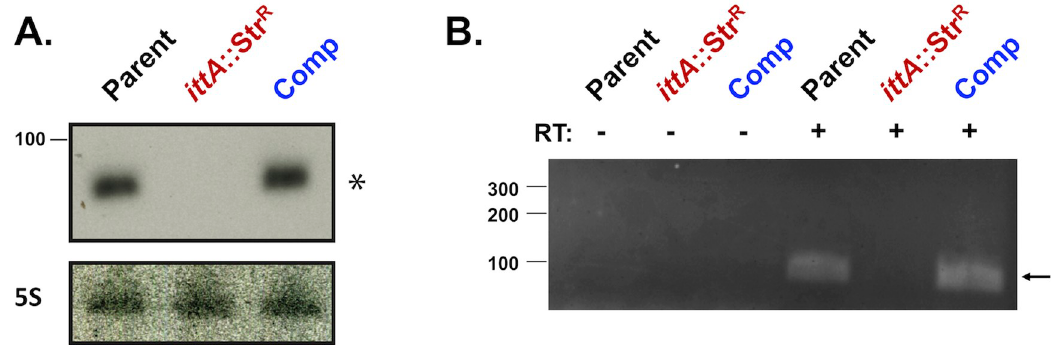
Fig 3. Confirmation that the ittA is not made in the mutant strain and is restored in the genetic complement. A. Northern blot of total RNA isolated from the parent strain ML23 (denoted Parent), the sRNA mutant strain ( ittA :Str R ), and the ittA cis complemented strain (denoted Comp). Detection of 5S from each strain serves as a loading control. B. RT-PCR using purified total RNA from the B . burgdorferi ML23 (Parent), sRNA mutant ( ittA :Str R ), and genetic complement (Comp) strains. The first three lanes had no reverse transcriptase (RT) added to the reactions (indicated with a “-“) whereas the next three lanes included reverse transcriptase (designated with a “+”). The DNA ladder is shown to the left and base pair values are indicated. The arrow on the right indicates the presence of the sRNA species observed in the parent and complement